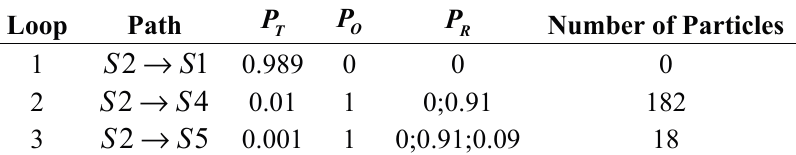
Table 1. Estimation process using look-ahead